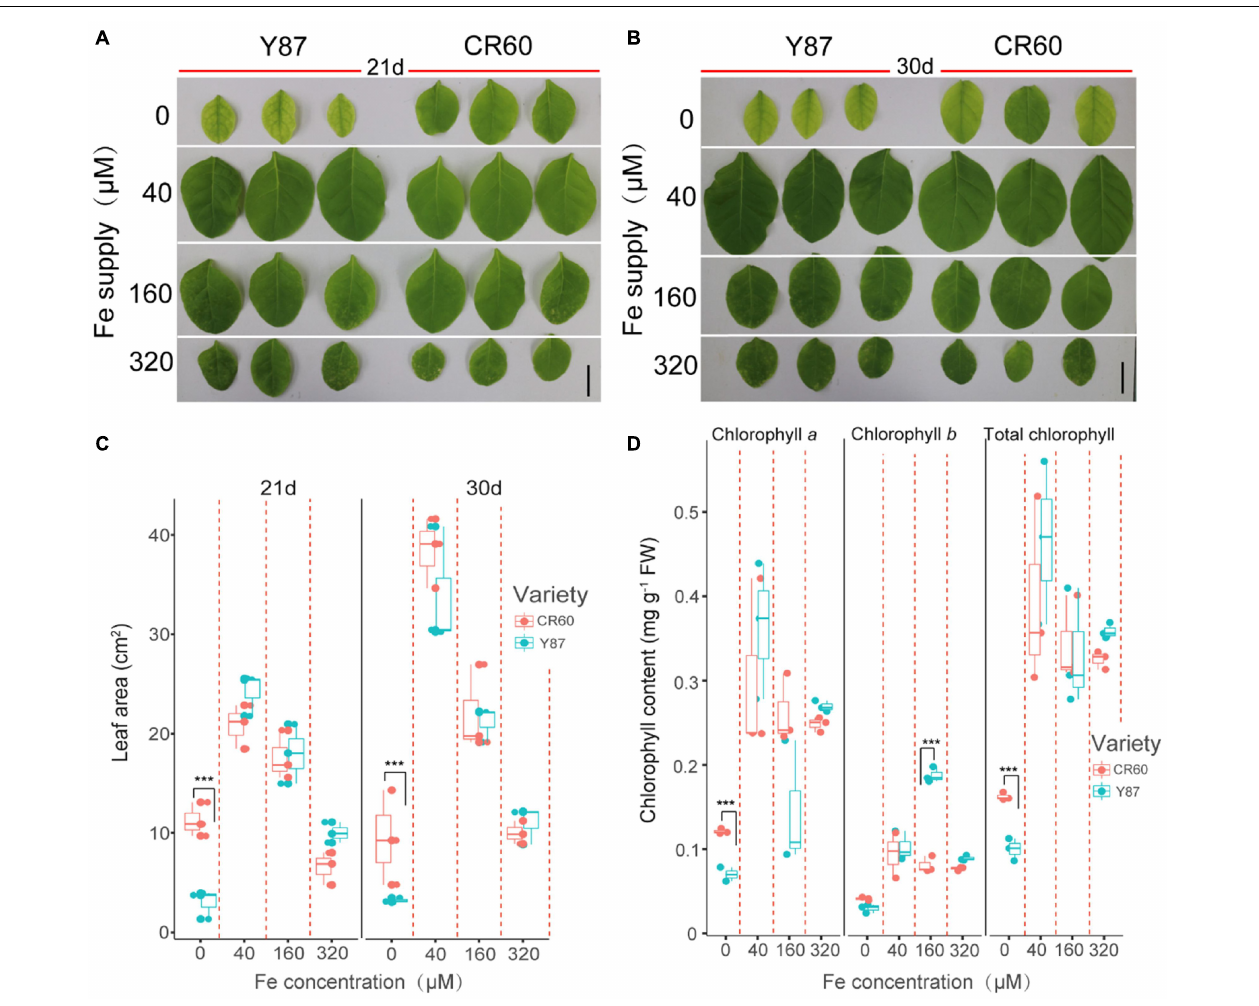
FIGURE 2 | CR60 had higher iron deficiency tolerance than Y87. Images (A,B) , leaf area (C) and chlorophyll concentrations (D) of the first fully expanded apical leaves of CR60 and Y87 after growing at different nutrient solution concentrations of iron (0, 40, 160, and 320 µ M) for 21 and 30 days. The experiment was conducted at least three times and showed similar results. For panels (C,D) data were collected from plants grown at differential iron supply for 21 days and were expressed as means ± SD ( n = 3). Asterisks indicate statistically significant differences between CR60 and Y87 (*** p < 0.001) as determined by the Student’s t